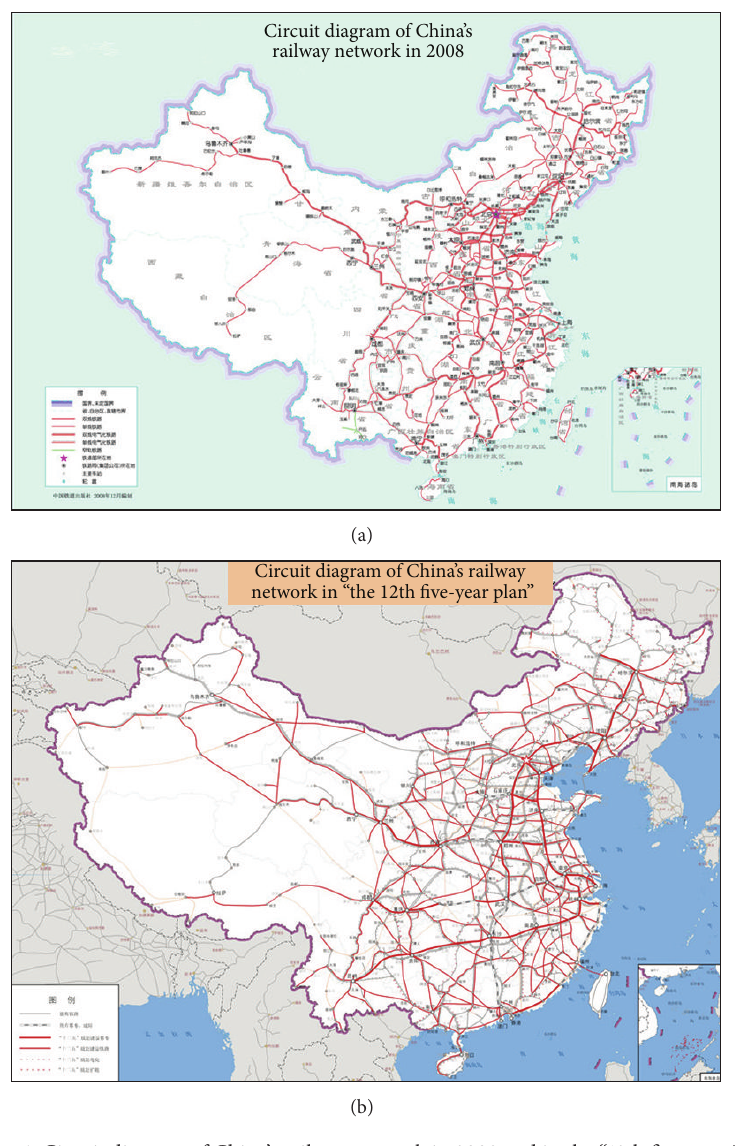
Figure 4: Circuit diagram of China’s railway network in 2008 and in the “12th five-year Plan.”